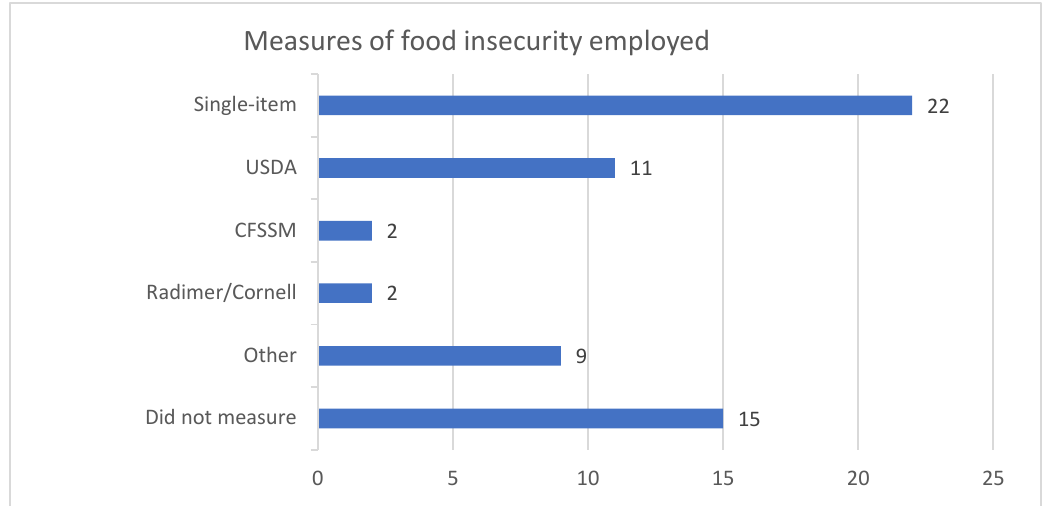
Figure 3. Tools used to measure food insecurity in the studies included in this systematic review.